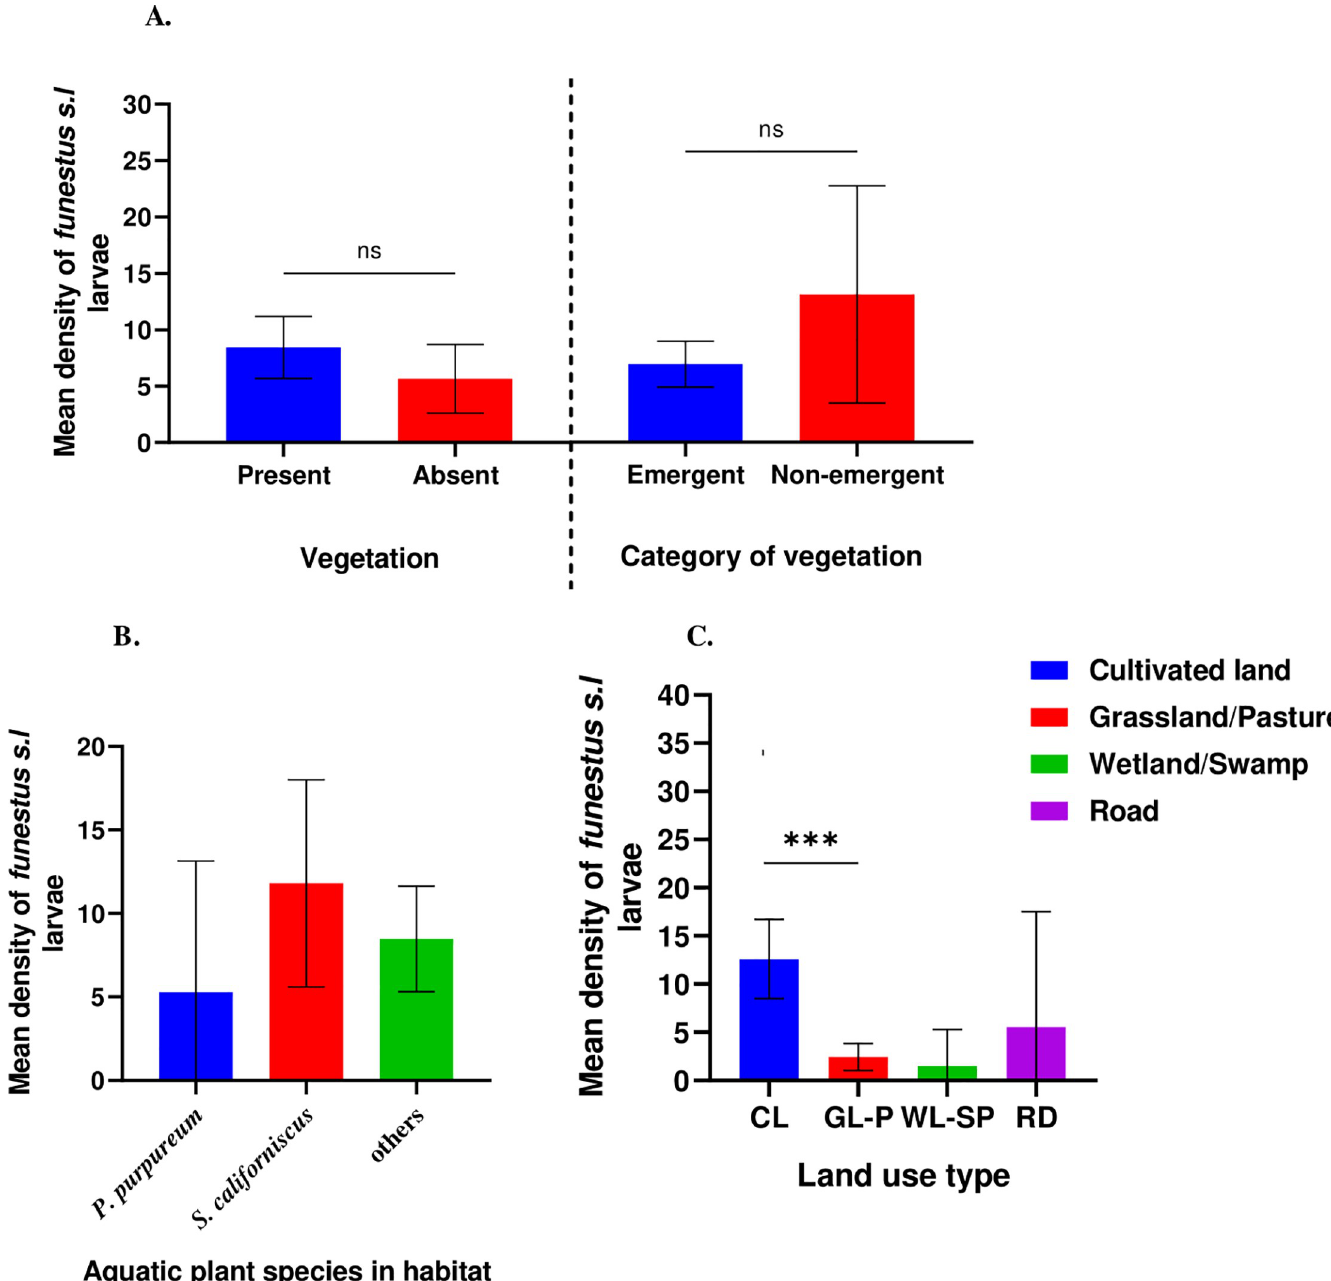
Fig 4. Association of habitat variables with An . funestus density (A) vegetation (present and absent) and category of vegetation (emergent and non-emergent), (B) aquatic species in the habitats, (C) land use type.